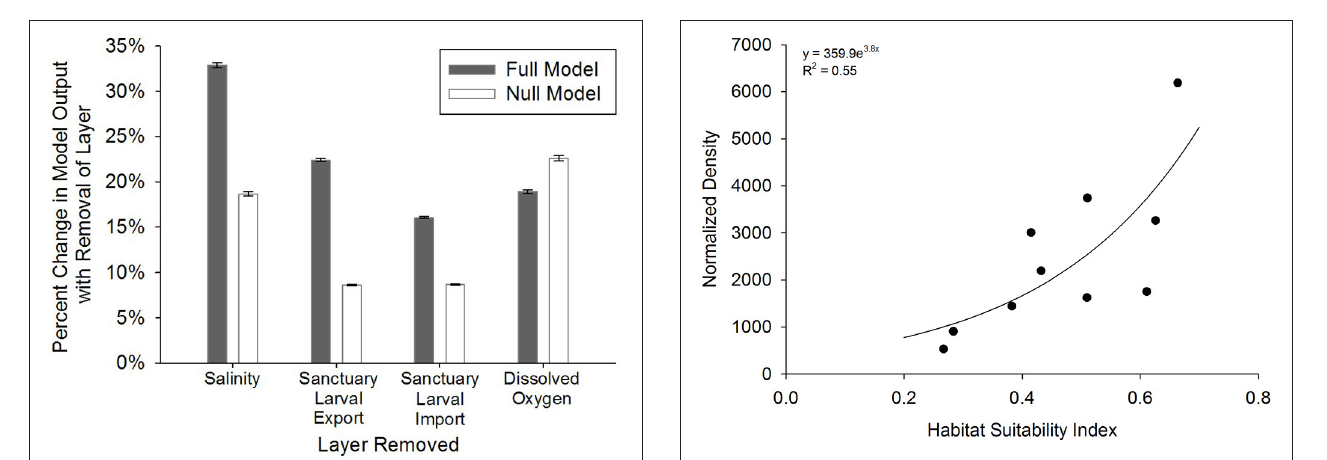
FIGURE 5 | Model sensitivity analysis where: (1) the four layers with the highest weights (full, stakeholder-weighted model; “Full Model”) were individually removed, (2) the remaining layers were proportionally re-weighted based on the weight of the removed layer, and (3) the percent change in model output was calculated on a cell-by-cell basis for removal of each layer. The same process was followed in the null, equally-weighted model (“Null Model”). Error bars represent standard error of the mean.